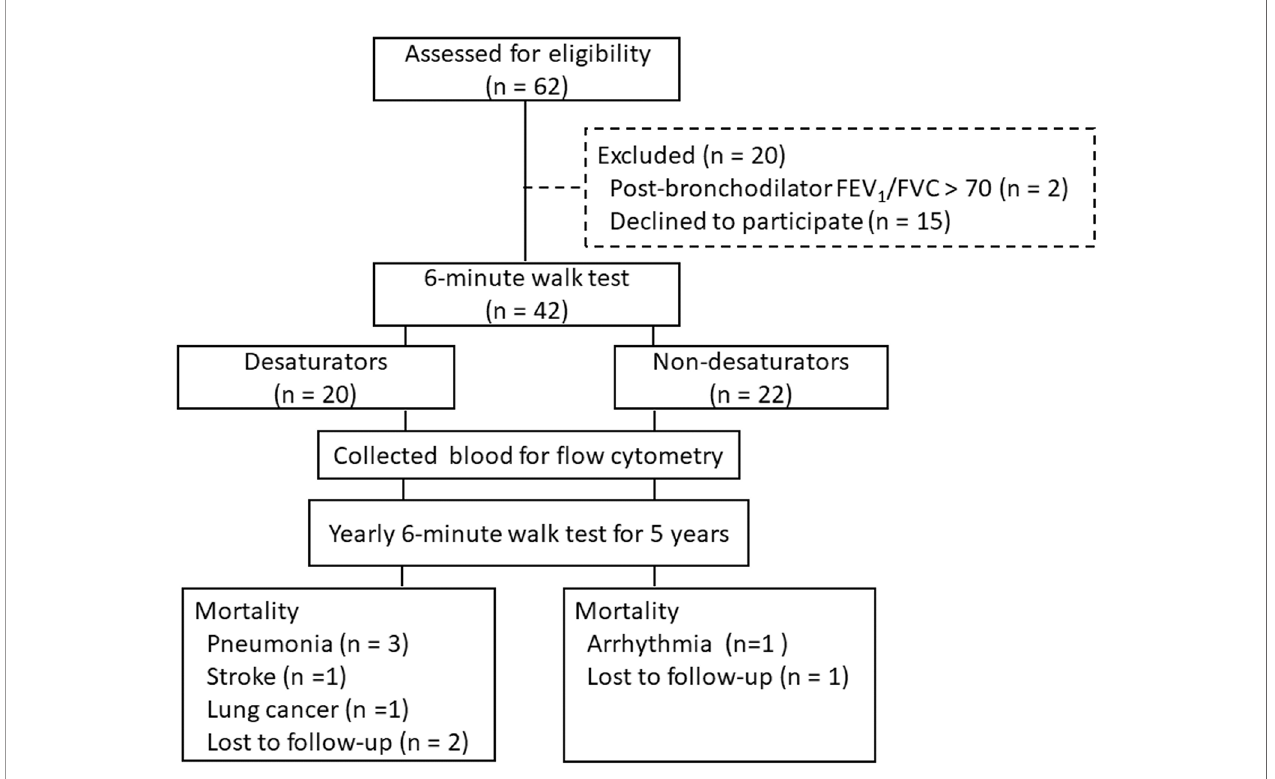
FIGURE 1 | The fl ow chart of enrolled